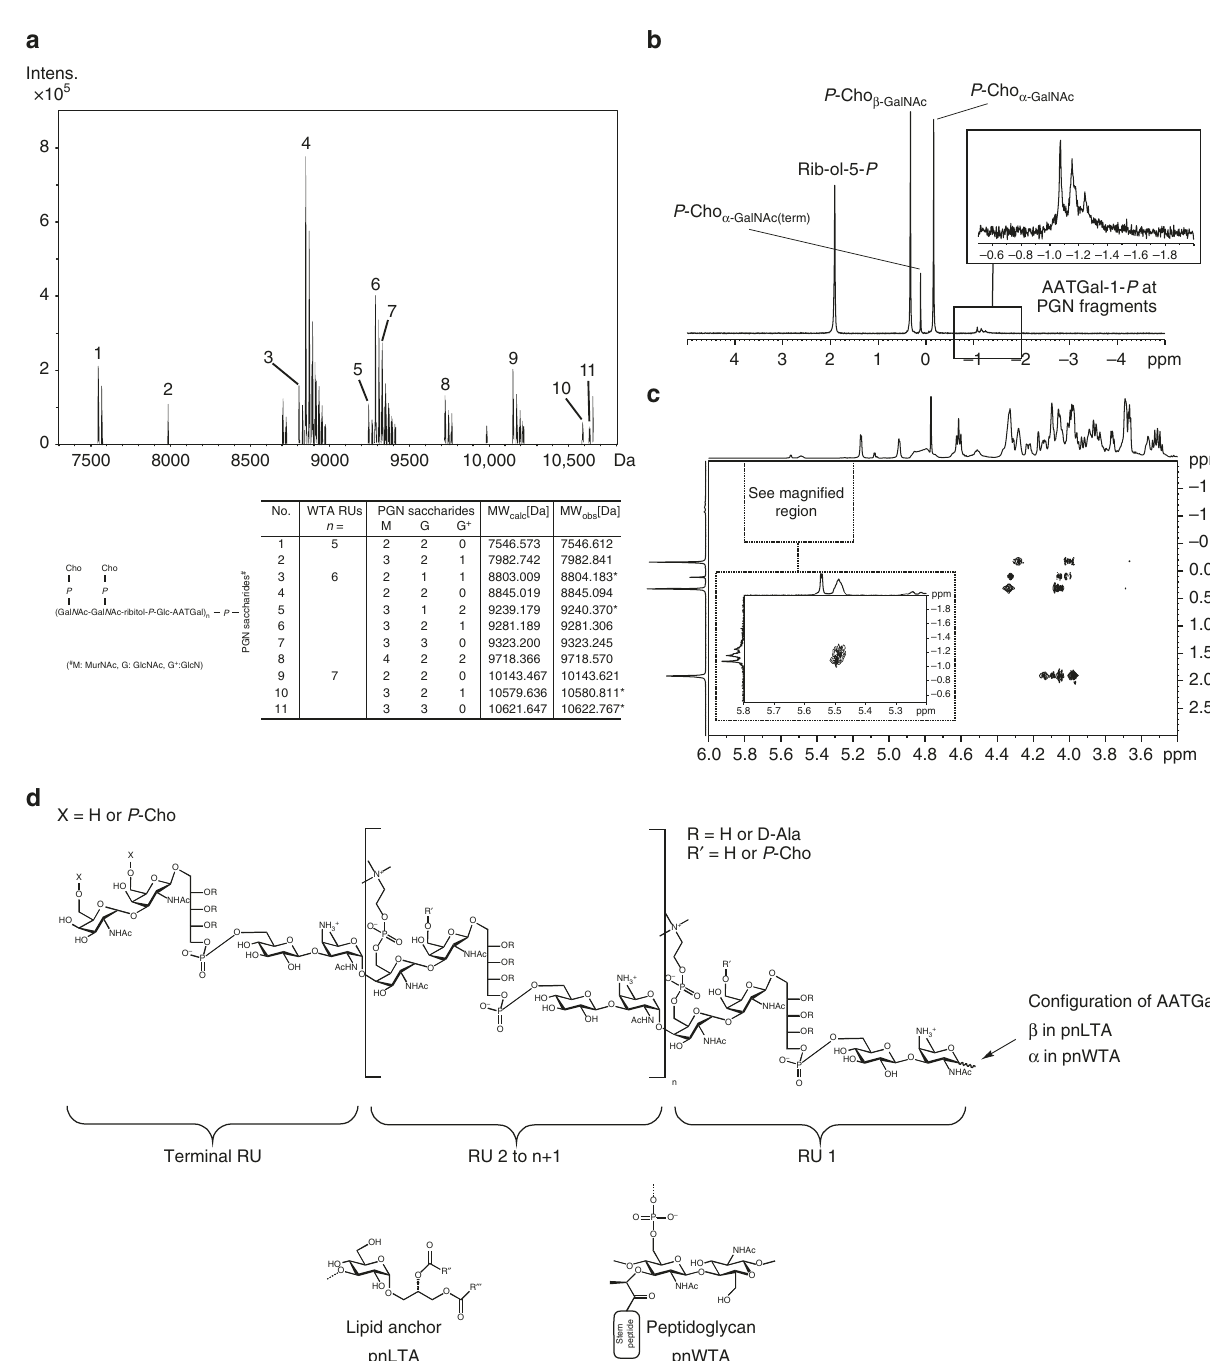
NATURE COMMUNICATIONS | 8: 2093 | DOI: 10.1038/s41467-017-01720-z |